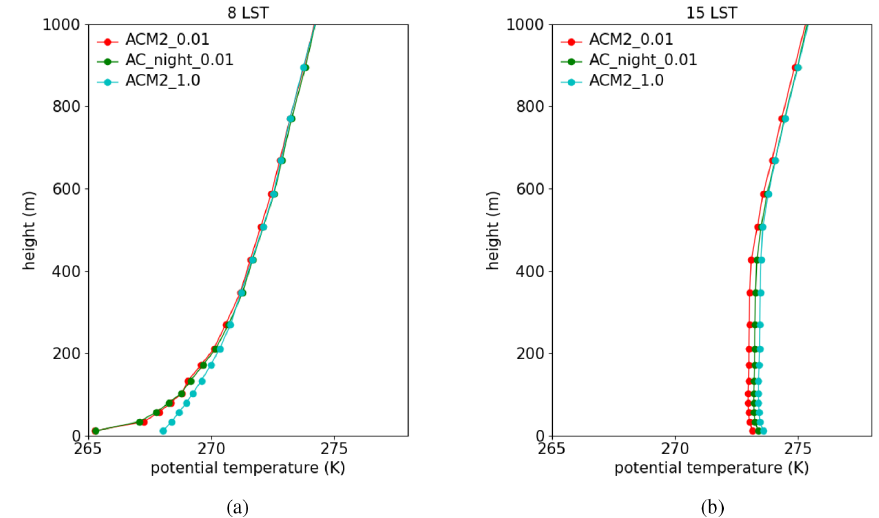
Figure 5. The vertical profiles of the potential temperature predicted by ACM2_0.01, ACM2_1.0, and AC_night_0.01 at (a) 08:00LST and (b) 15:00LST averaged over the simulated